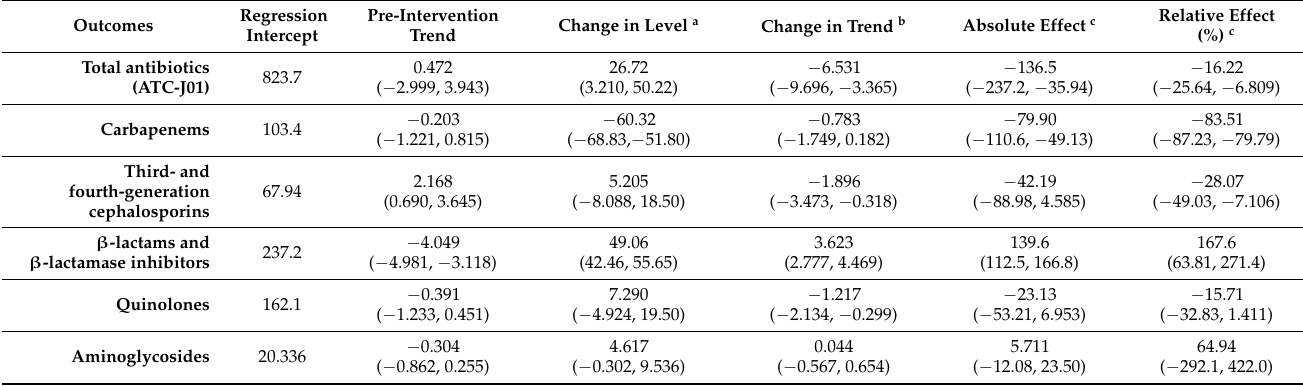
Table 1. Interrupted time-series analysis of changes in trends of antimicrobial consumption.